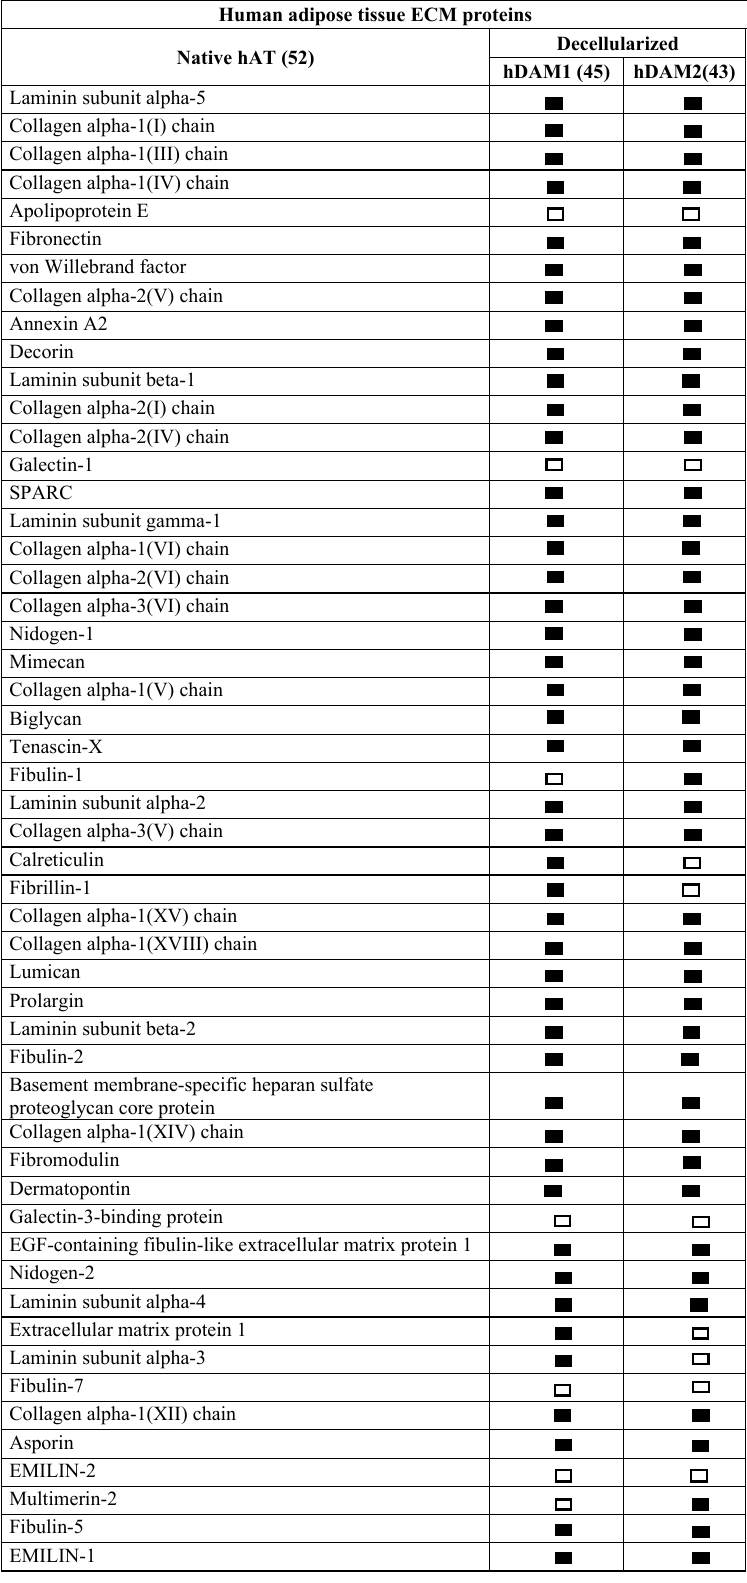
Figure 1. Human extracellular matrix (ECM) protein composition before (native) and after adipose tissue (AT) decellularization by method 1 (hDAM1) and method 2 (hDAM2).